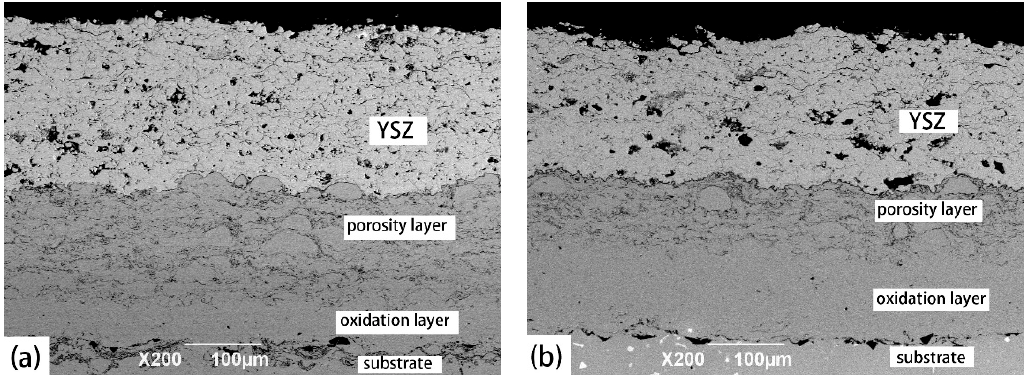
Figure 2. The typical microstructure of the as-deposited TBC: ( a ) type A and ( b ) type B.